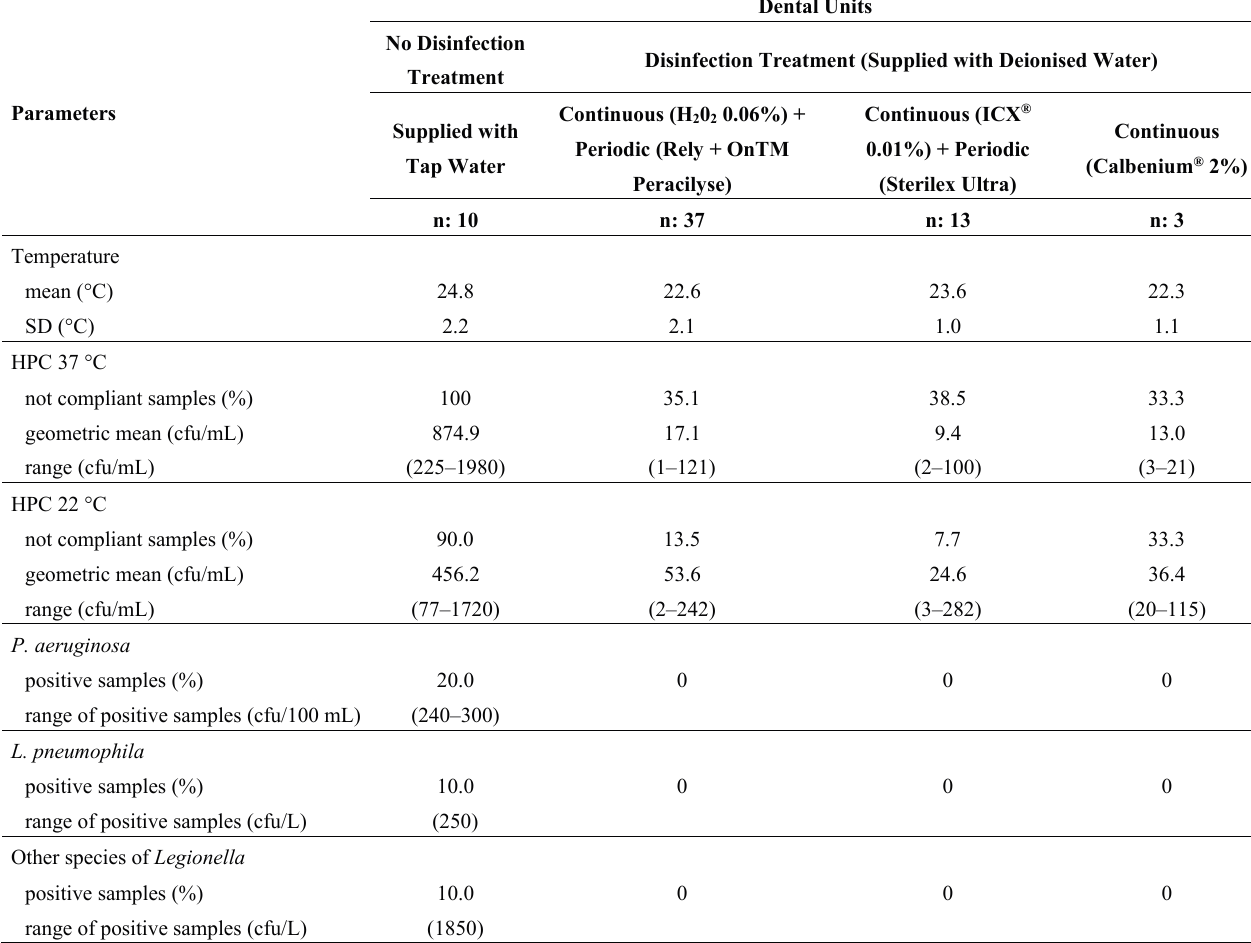
Table 5. Microbial contamination values of water samples from dental unit water systems after implementation of the risk management